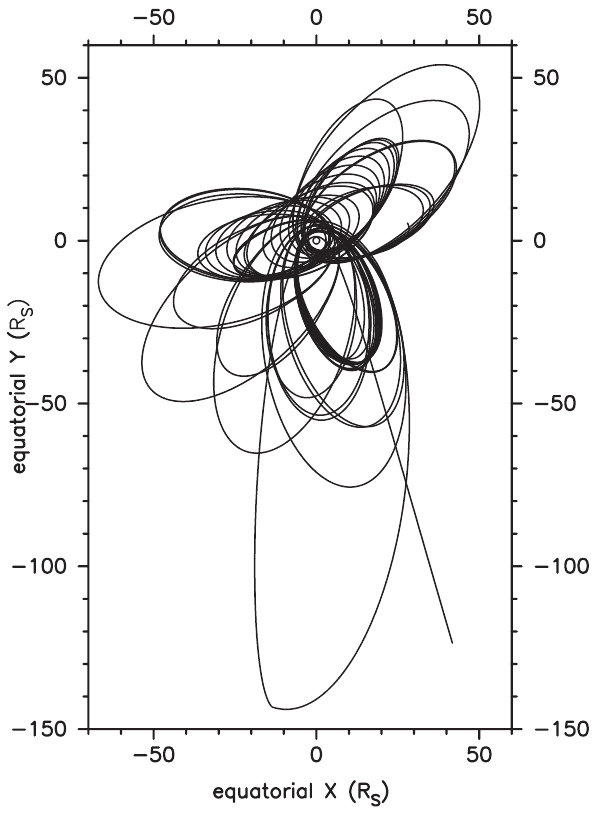
Fig. 1. Orbits of the Cassini spacecraft in the equatorial x-y plane Figure 1 during the data sampling period. The spacecraft covers all local times, latitudes ranging from − 50 ◦ to +60 ◦ , and a radial distance in the range 3 R S <r < 100 R S